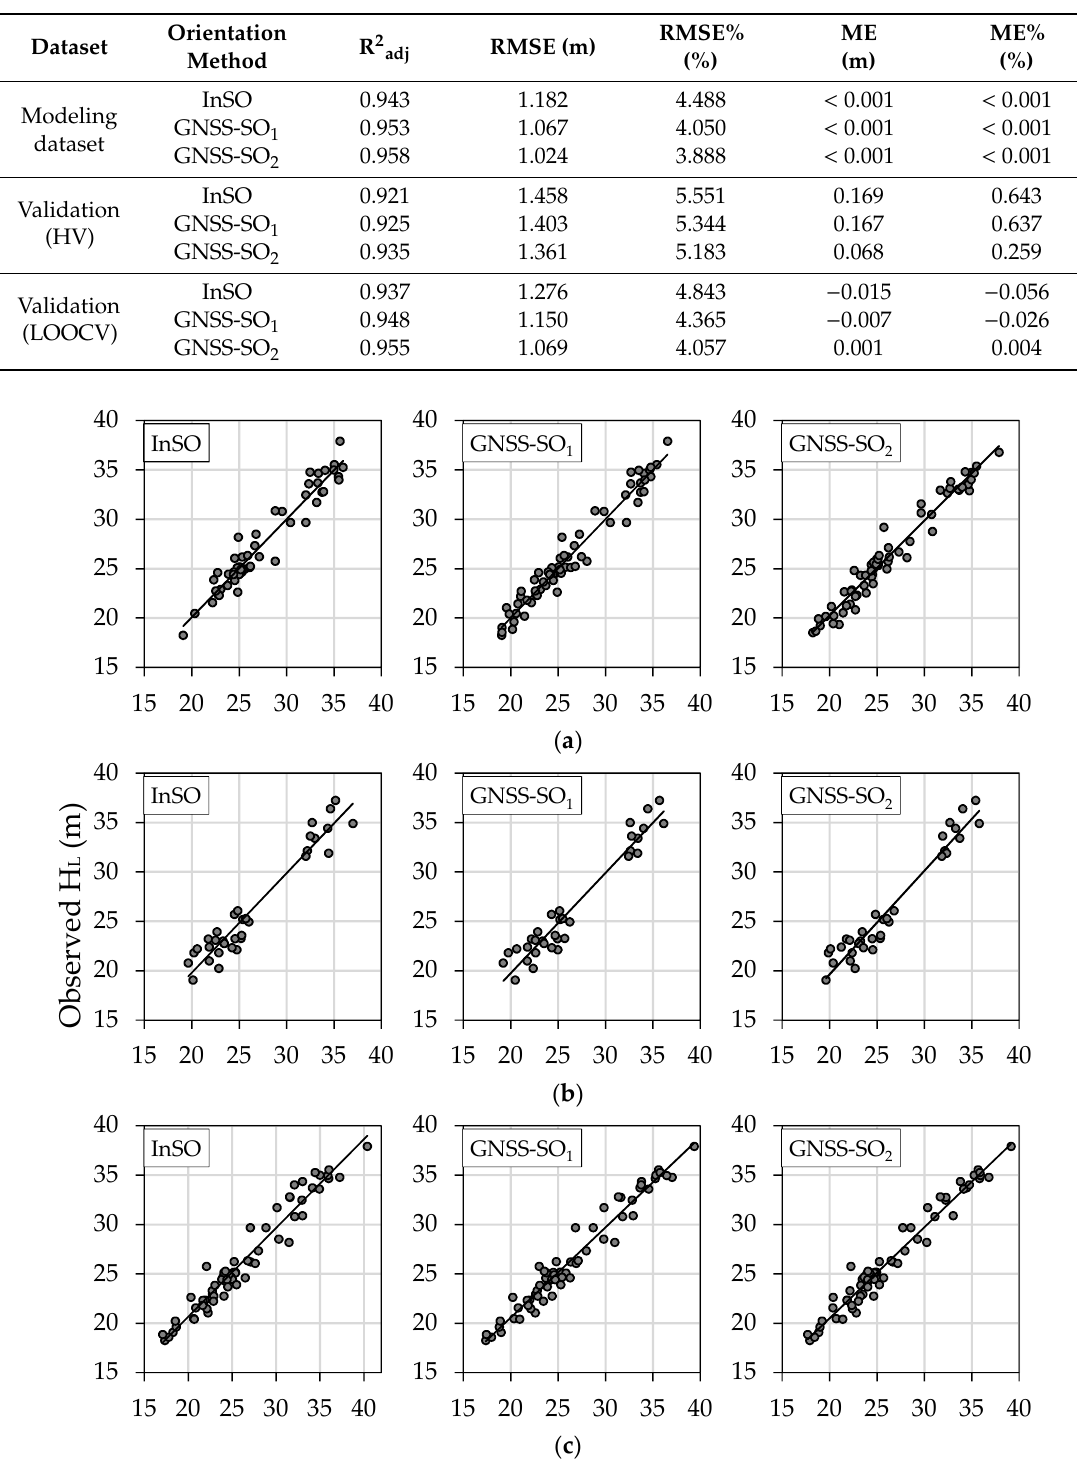
Table 6. Results of multivariate linear regression (modeling dataset) and validation results (HV and LOOCV) for selected plot-level H L models described in Table 5.